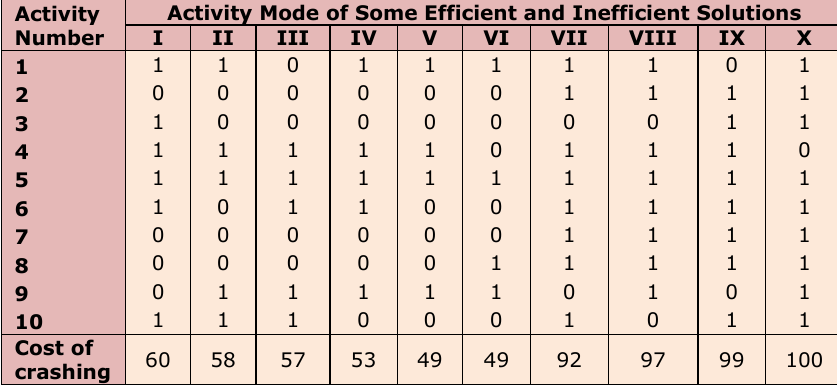
Table 4. Some solution generated by simulation in different